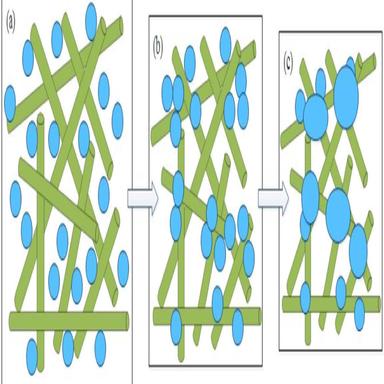
Microstructures of the PFMs with different densities: (a) S1, (b) S2, (c) S3, (d) S4.